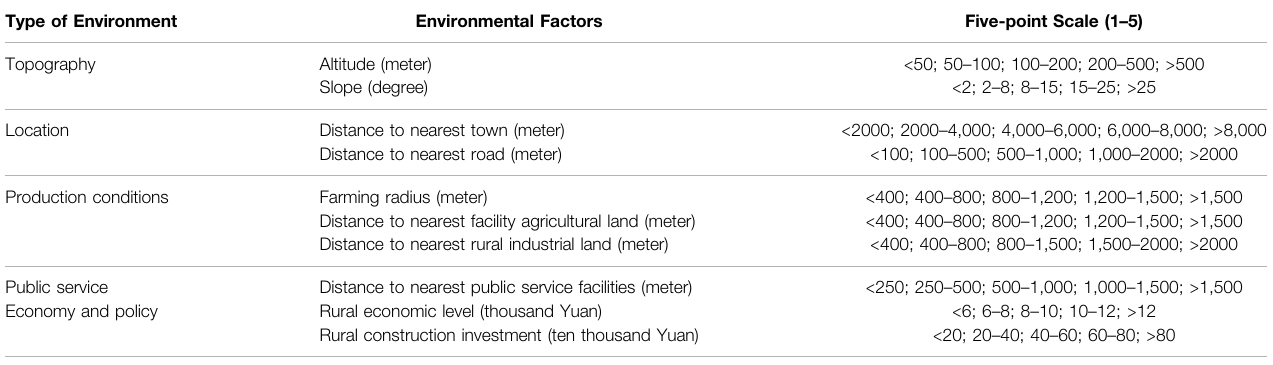
TABLE 2 | Grading criteria for major environmental factors.